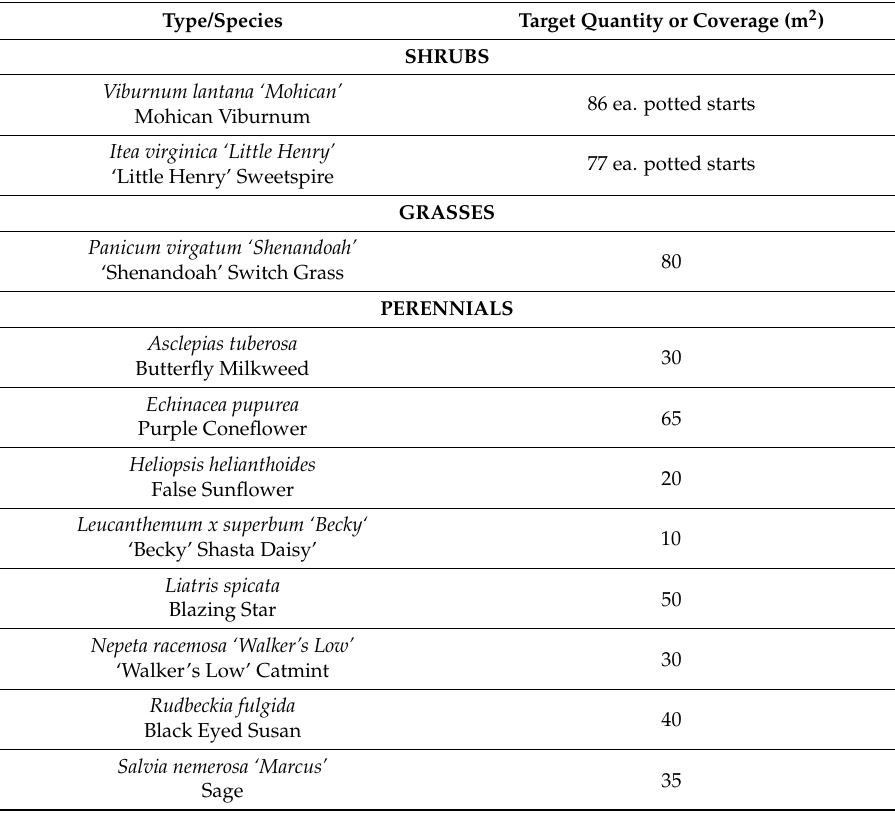
Table 1. Plant type and species, St. Francis rain garden, Cincinnati